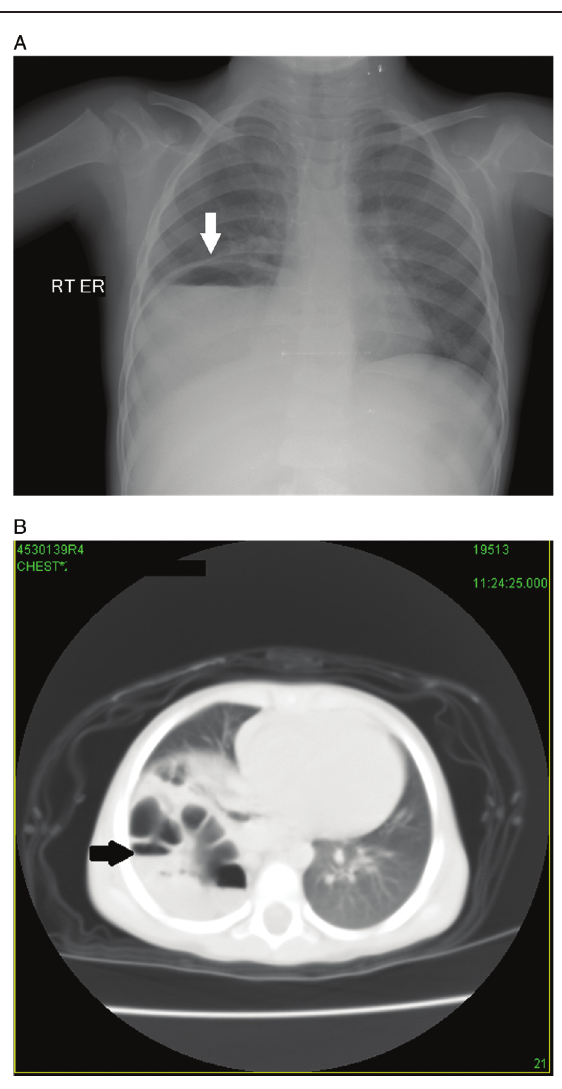
Final diagnosis: delayed presentation of right-sided congenital diaphragmatic hernia